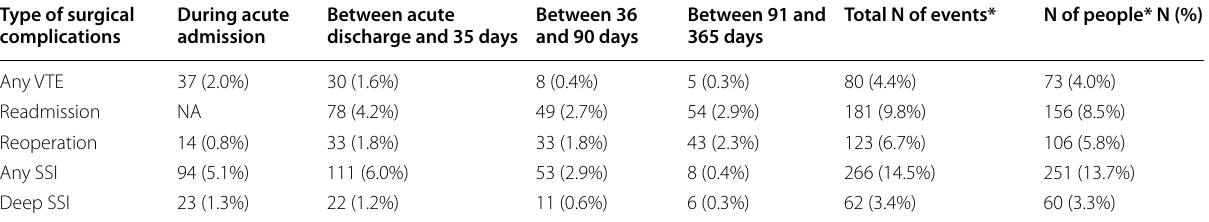
Table 3 Surgical